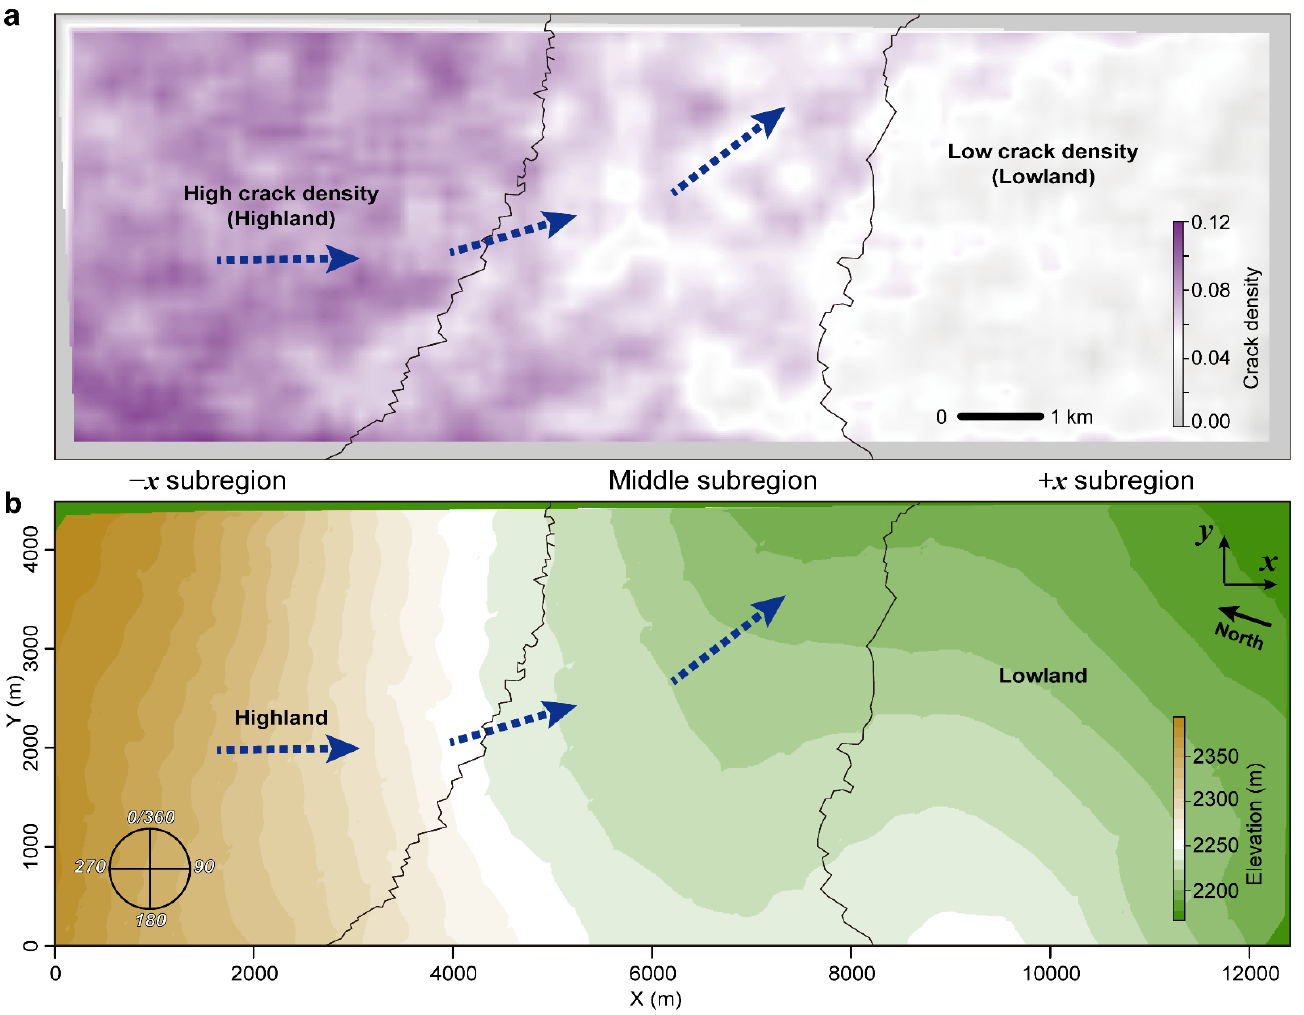
Figure 5. The illustration of possible uplift or subsidence. ( a ) Distribution of polygon edge density. ( b ) Elevation distribution, obtained from the MOLA database (https://attic.gsfc.nasa.gov/mola/ (accessed on 1 September 2022)). A set of dashed arrows from the highland to the lowland indicate the possible direction of the uplift or subsidence.